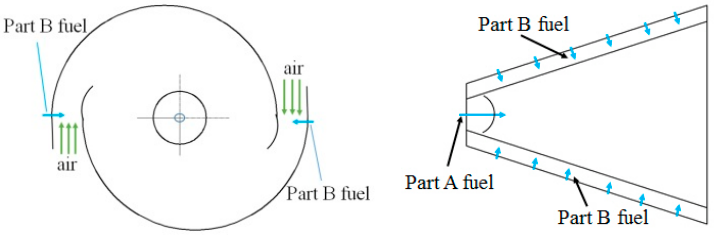
Figure 2. Schematic diagram of conical swirler at low operating condition.